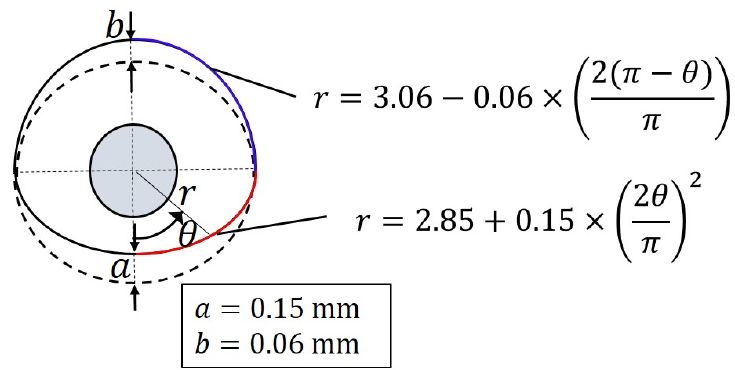
Figure 9. Cam design of previous prototype.